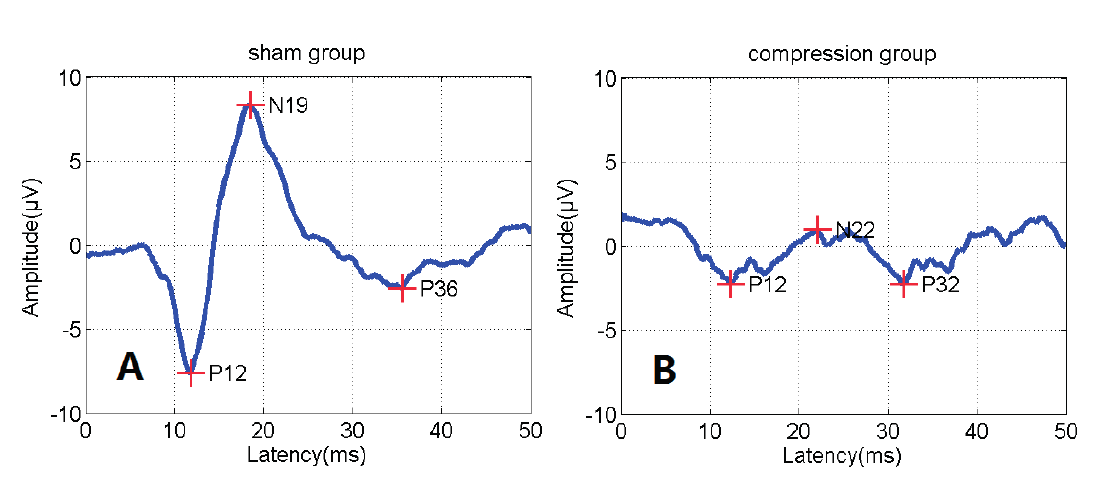
Figure 2. A sample of latency prolongation and amplitude reduction of somatosensory evoked potentials (SEP) from normal status ( A ) to compression status ( B ).